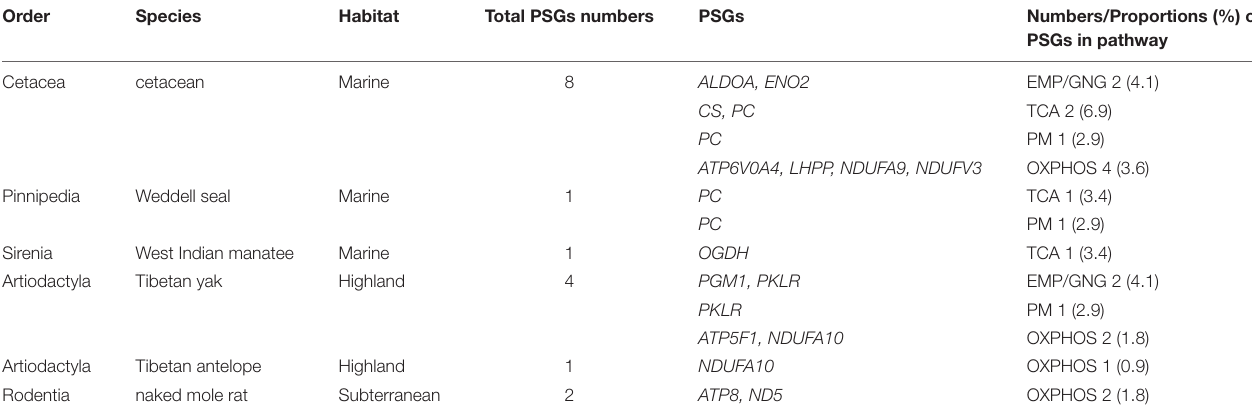
TABLE 1 | Positively selected genes (PSGs) in hypoxia-tolerant mammals after multiple-testing correction (FDR). Order Numbers/Proportions (%) of